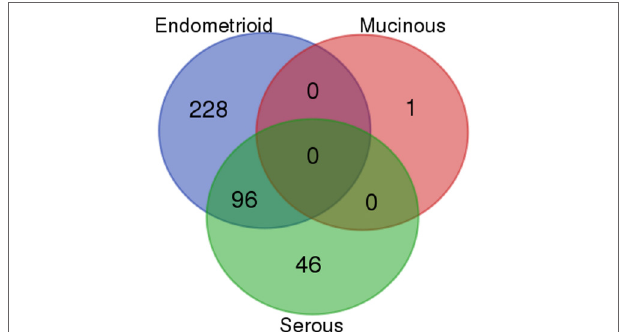
FigUre 2 | Venn diagram of the overlap of differentially expressed reactome pathways between ovarian cancer subtypes . The number of overlapping Reactome pathways from the gene set analysis of ovarian clear cell carcinoma compared to the high-grade serous, mucinous, and endometrioid subtypes, respectively.